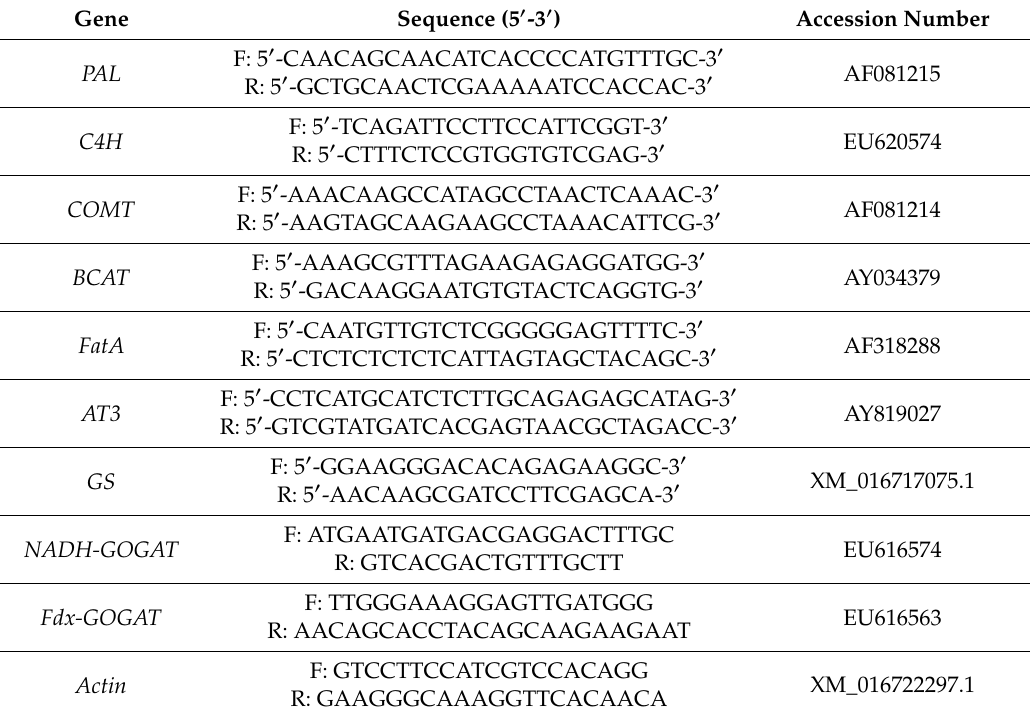
Table 1. Primers used for